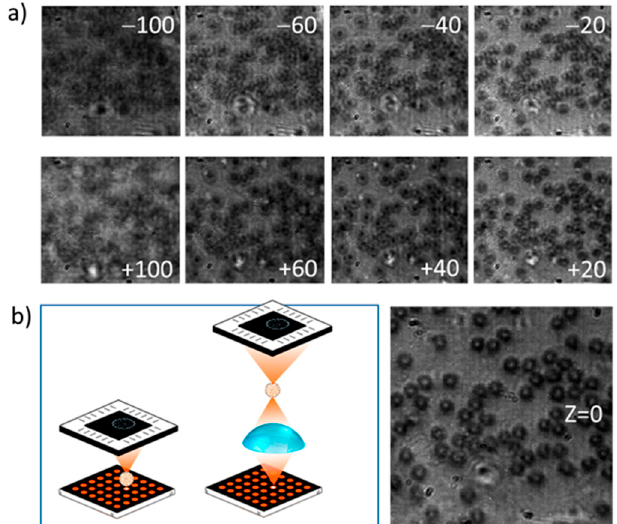
Figure 8. (a) Images from smear blood obtained with light source 3 and the sample located 100, 60, 40 and 20 mm over or below the spot plane. ( b ) Schematics of the without-lens and with-lens setups (at left) and the focused image (Z = 0, at right). All images show the same 100 μ m × 100 μ m area.